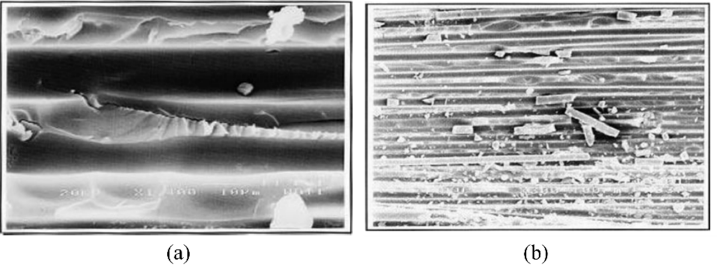
Figure 6. SEM image of fractured surface after mode I fatigue loading: ( a ) path cleavage ( b ) fibre and matrix fragments